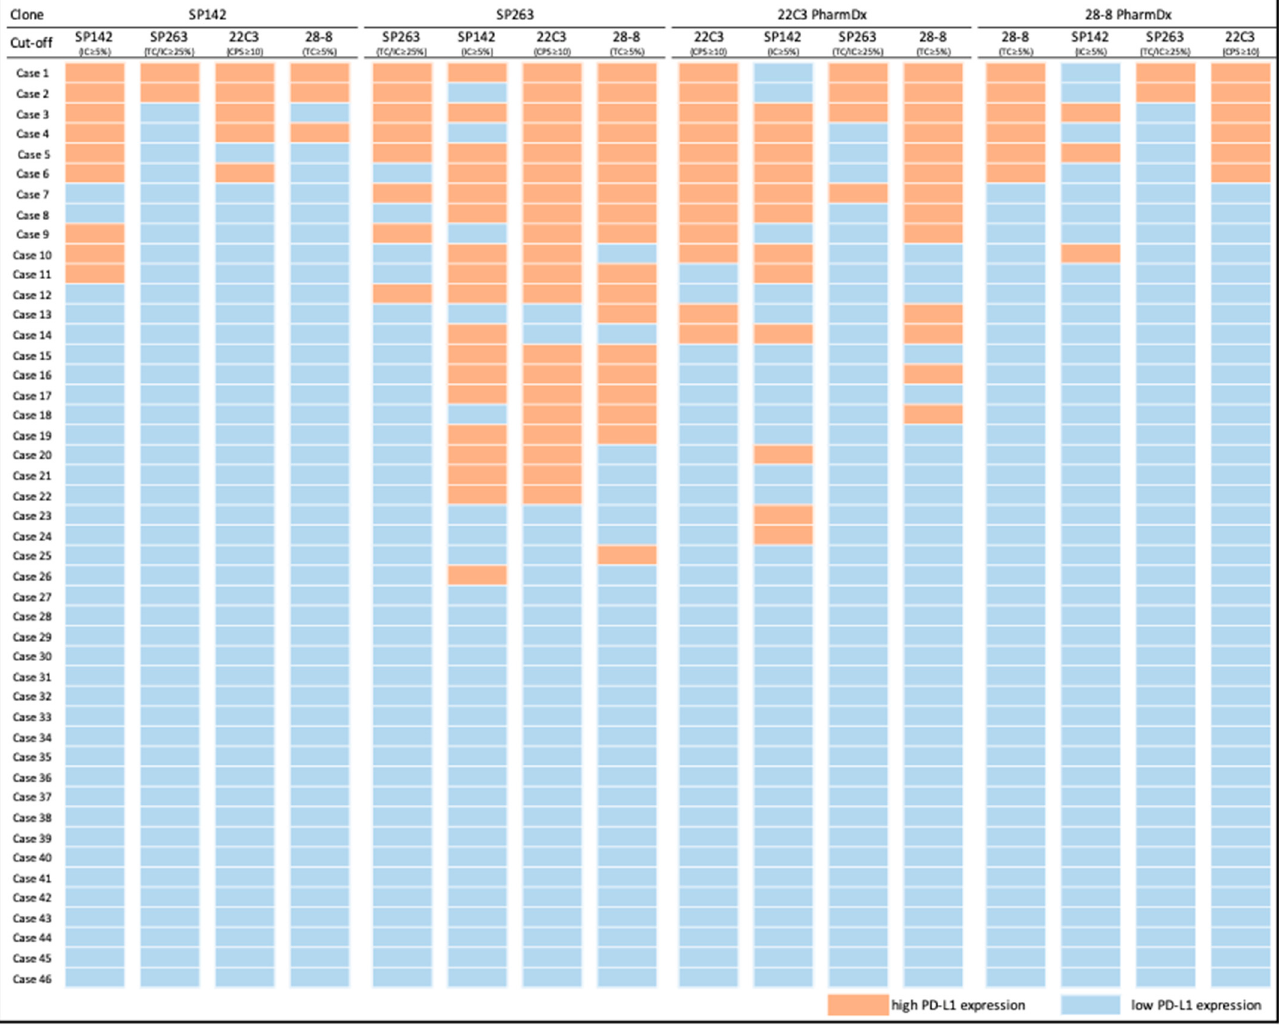
Figure 3. Low/high PD-L1 expression defined by a combination of staining clone and four clone-specific cutoffs.